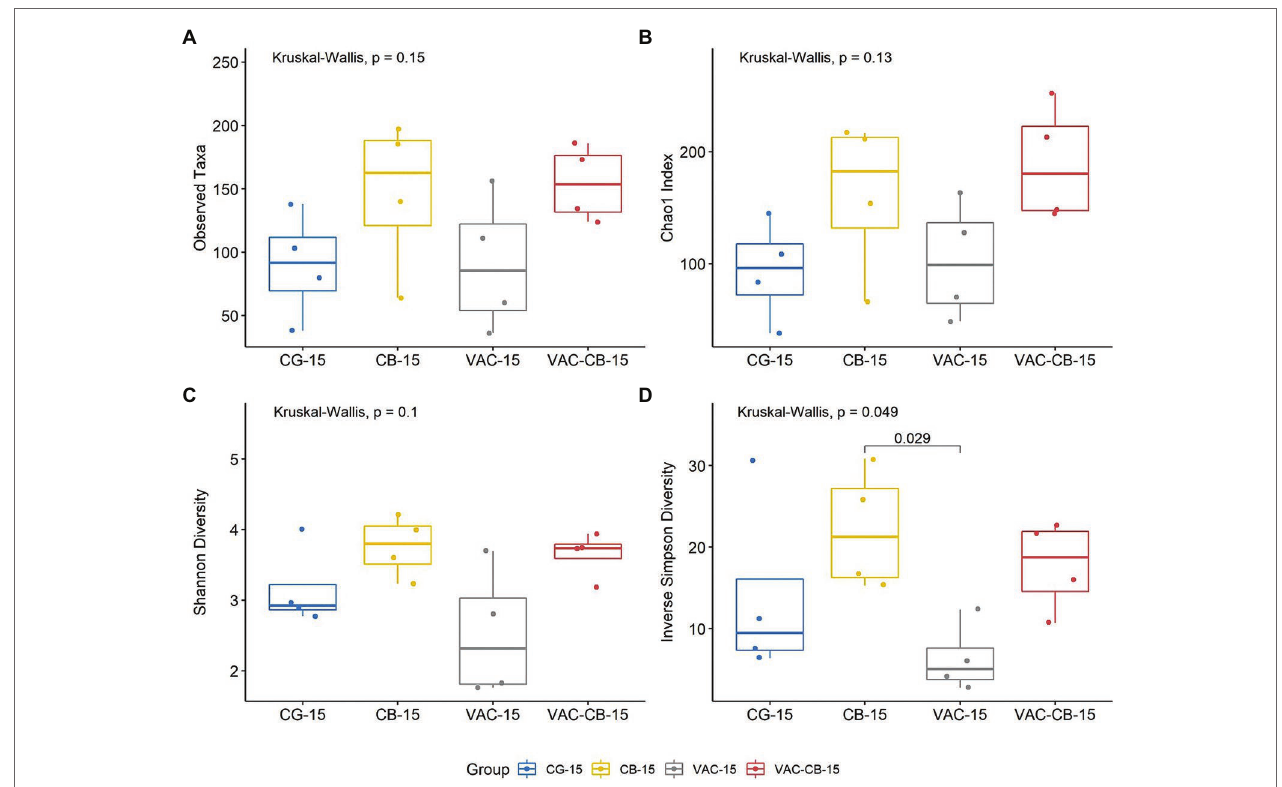
FIGURE 3 | Comparison of intestine microbiome alpha diversity from various pretreatment groups at 15 days old. The alpha diversity indices including observed taxa (A) , chao1 index (B) , Shannon diversity (C) , and inverse Simpson diversity (D) were analyzed using the alpha function from the microbiome package. Boxplots were drawn using the ggboxplot function from the ggpubr package in R version 4.1.0. Alpha diversity was tested using the Kruskal–Wallis test with post hoc Dunn tests. The Wilcoxon test was performed to determine significant difference between groups. The box plots show the median, and whiskers show 25 and 75%